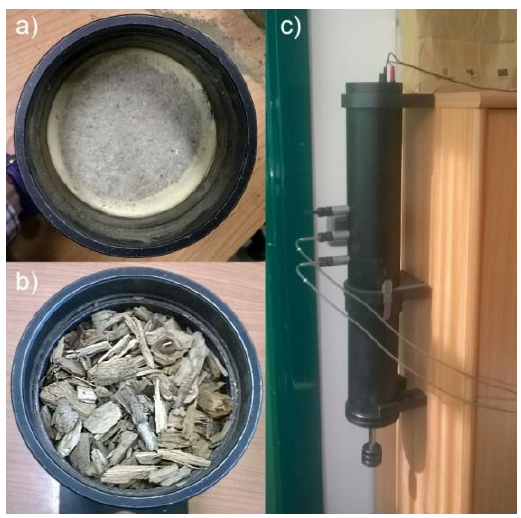
Figure 9. ( a ) Mineralized; ( b ) Unbound sample in the sample holder; and ( c ) Tube vertical configuration for the absorption